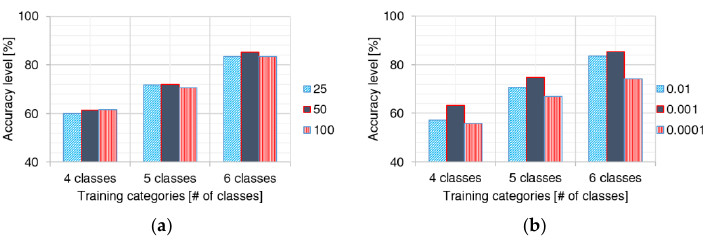
Figure 7. Network performance at training in terms of number of epochs ( a ) and learning rates ( b ) for different classes.